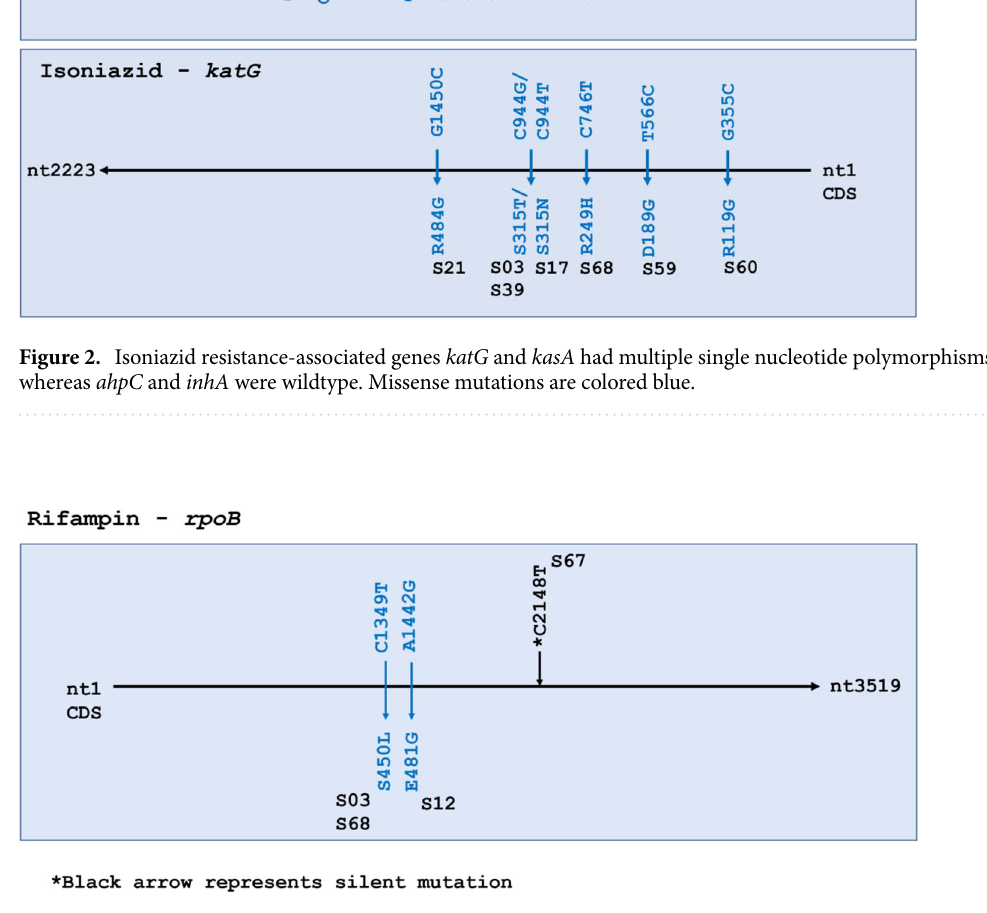
Figure 3. Rifampin resistance-associated gene rpoB had only three single nucleotide polymorphisms (SNPs). Missense mutations are colored blue. S67 had a silent mutation represented by the *black